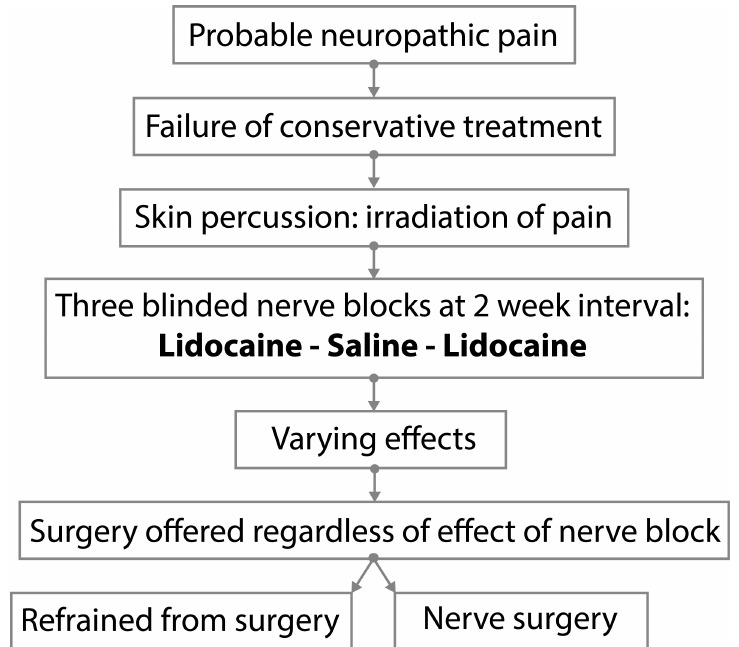
Fig 2. The LUMC protocol applied exclusively to patients with persistent postsurgical or nerve injury–induced probable neuropathic pain related to sensory nerves. All patients had positive sensory signs confined to the innervation territory of the damaged nervous structure and had insufficient pain reduction or severe side effects from pharmacotherapy. The involved nerve is blocked three times in 4 weeks (with a 2-week interval between injections) and consists of two single-blind injections with lidocaine and one with placebo. All patients are given the opportunity of surgery irrespective of the outcome of the block